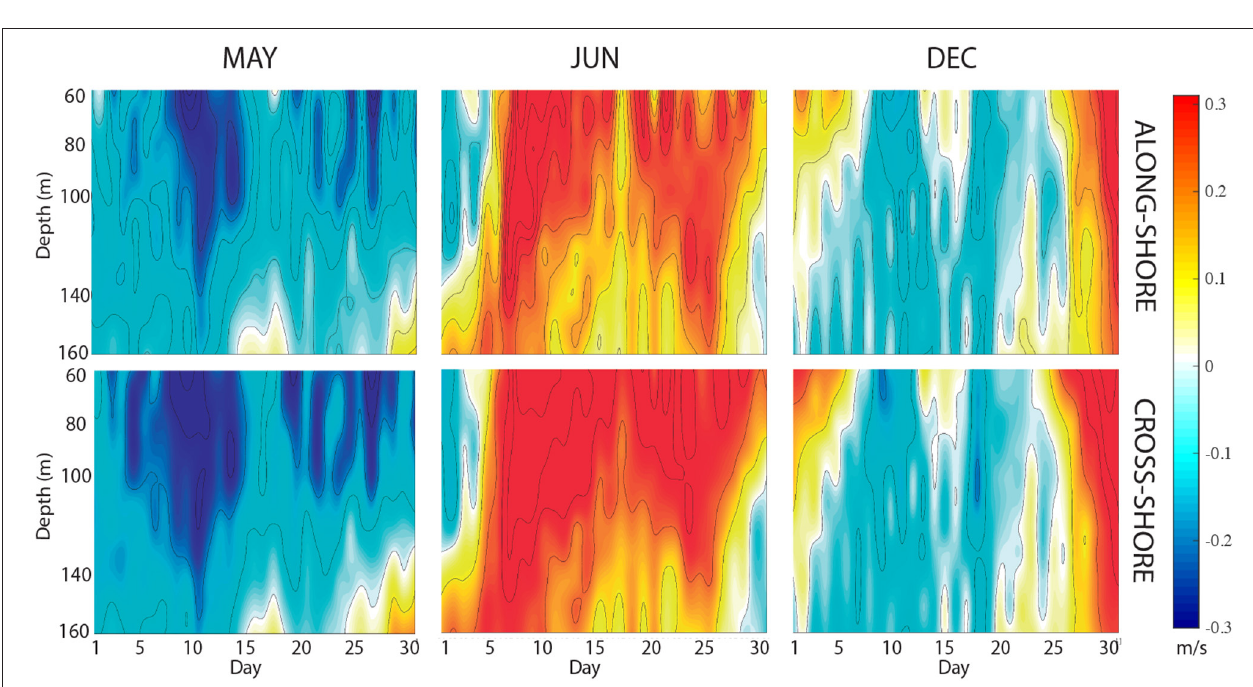
FIGURE 6 | Along-shore (top) and cross-shore (bottom) currents off La Guajira (ADCP2, Figure 1 ) during May (left), June (center), and December (right) 2007. Positive (negative) velocities are southwestward (northeastward) and northwestward (southeastward) for along-shore and cross-shore components, respectively.